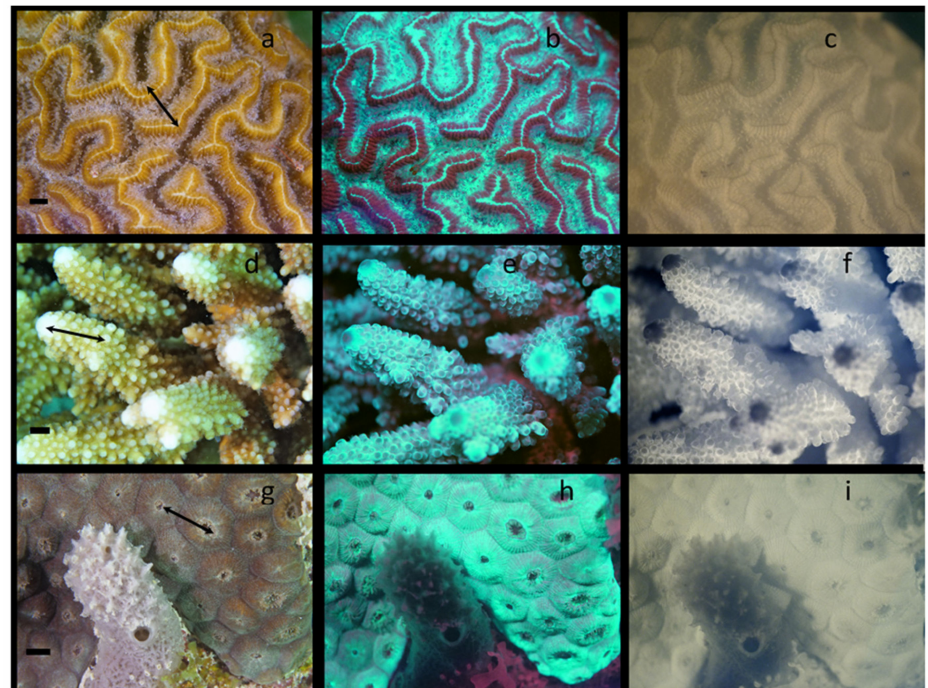
Figure 6. Images from three di ff erent coral species from di ff erent locations. Visible images ( a , d , g ); visible fluorescence images ( b , e , h ); and NIR Chl fluorescence images ( c , f , i ). ( a – c ) Diploria strigosa from Carriacou, Grenada in January; ( d – f ) Acropora sp. from the Egyptian Red Sea in February; ( g – i ) Montastraea cavernosa from the Florida Keys in March. Arrows on visible images represent the regions used for further digital image analysis in Figure 7. The scale bar in each visible image is approximately 10